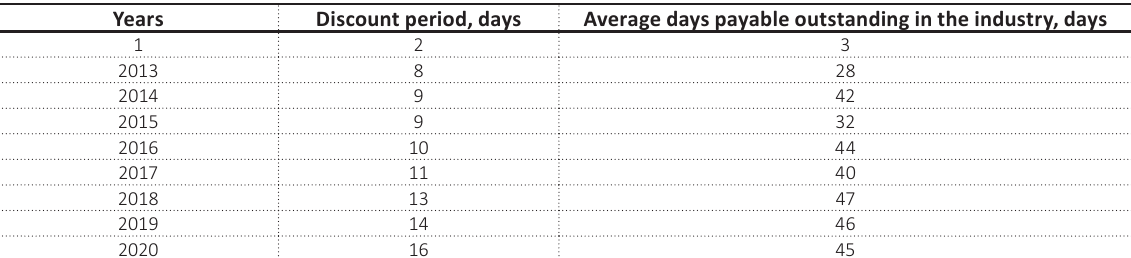
Source: Calculated by the